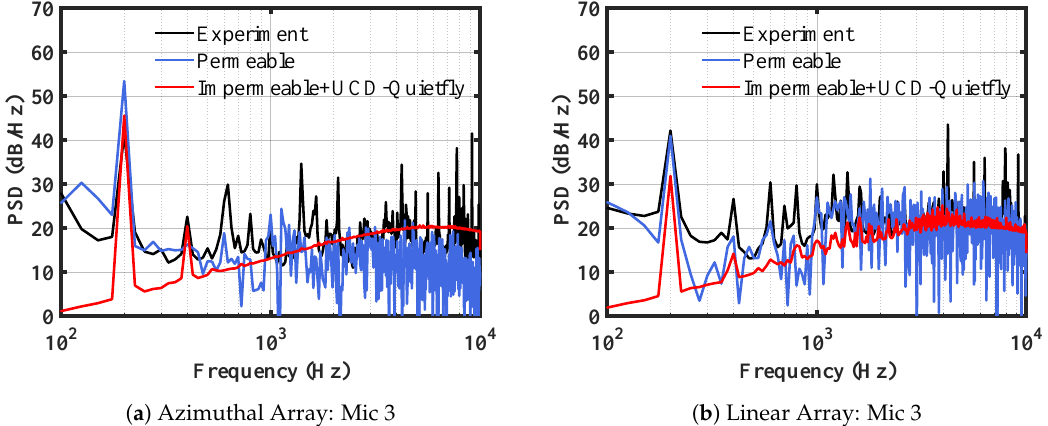
Figure 16. Impermeable and permeable surface calculations of the single rotor in hover at 6000 RPM using Helios/PSU- WOPWOP, compared to experimental